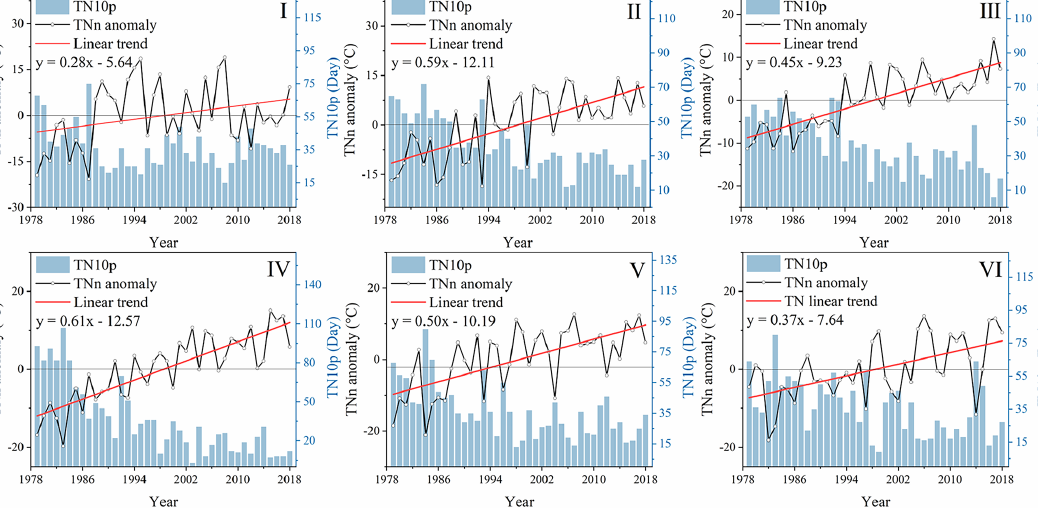
Figure 13. Multi-axis diagram of TNn anomaly, TN10p, and T min linear trend graphs. The broken black line represents the TNn anomaly, the red line represents the linear regression of the TNn anomaly, and the blue histogram represents the TN10p change